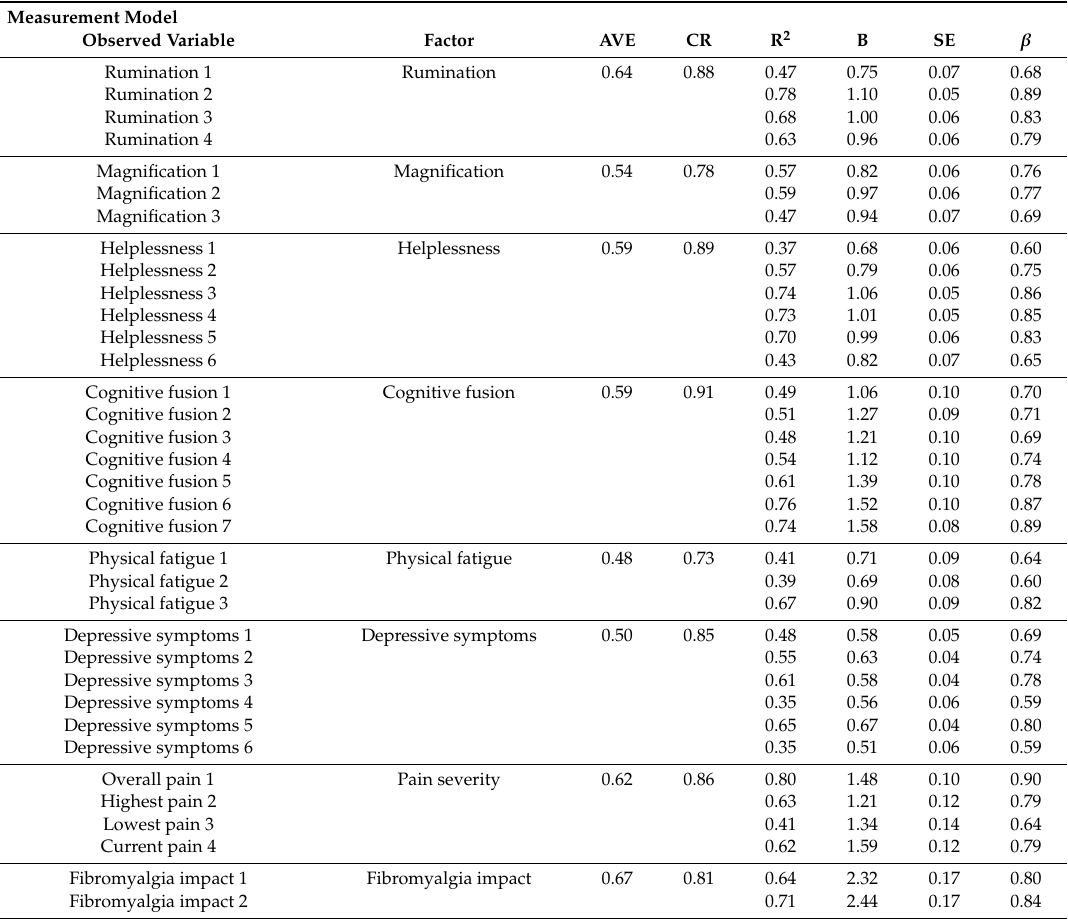
Table 2. Validity, reliability, and estimates of the measurement